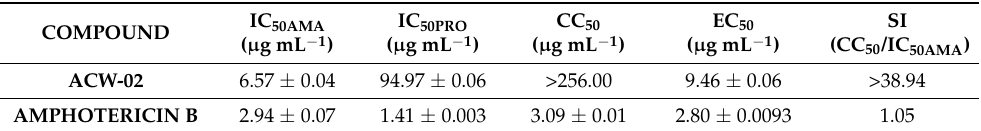
Table 1. Data on 50% growth inhibition of L. amazonensis , cytotoxic concentration on macrophages (CC 50 ), concentration that induces stimulatory effect on macrophages (EC 50 ), and selectivity index (SI), of ACW-02 and positive control Amphotericin B.